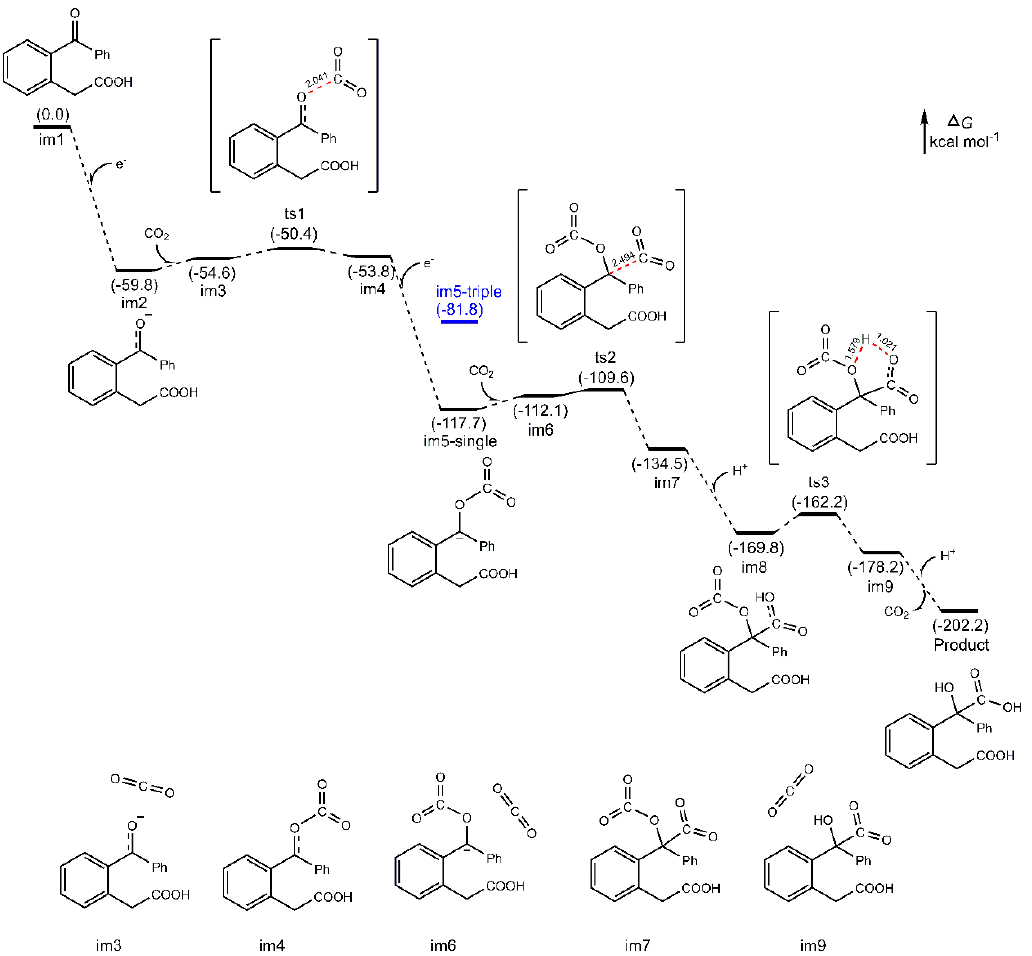
Figure 2. Energy profiles for the electro-carboxylation of o -acylphenylacetic acid. The relative Gibbs energies are given in kcal mol − 1 , at 298 K, 1 atm. All the geometries are optimized in DMSO solvent at the M062X / 6-311 + G(d) level based on the polarized continuum model (SMD). The bonding length is reported in Å.